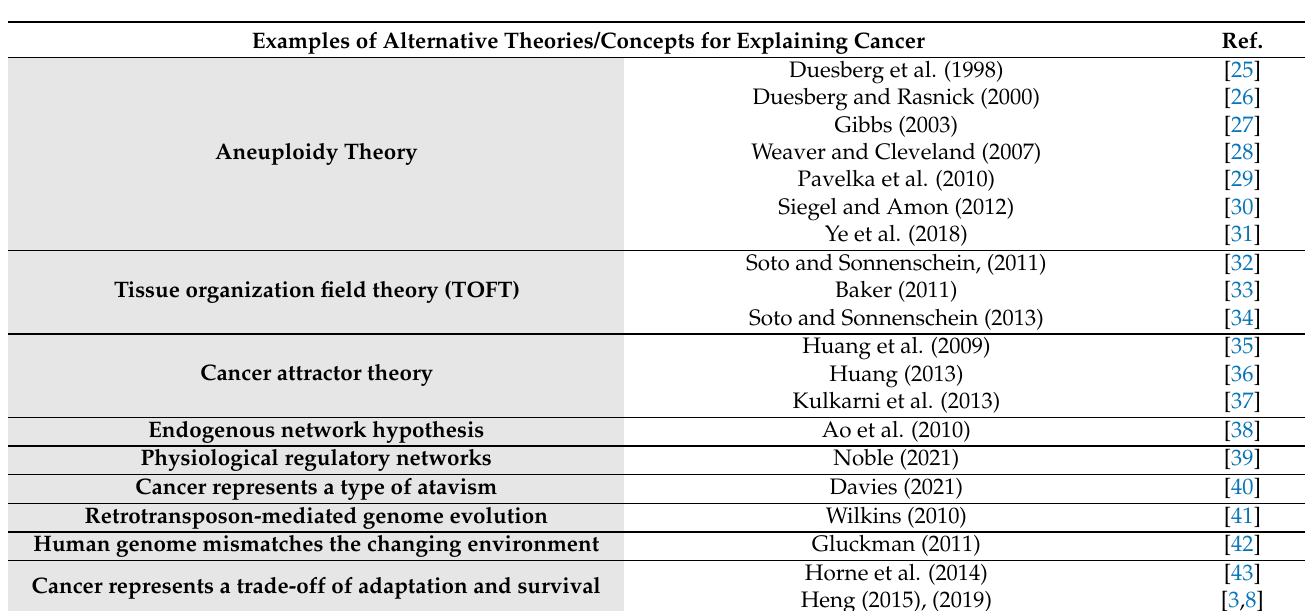
Table 1. Examples of alternative theories/concepts for explaining